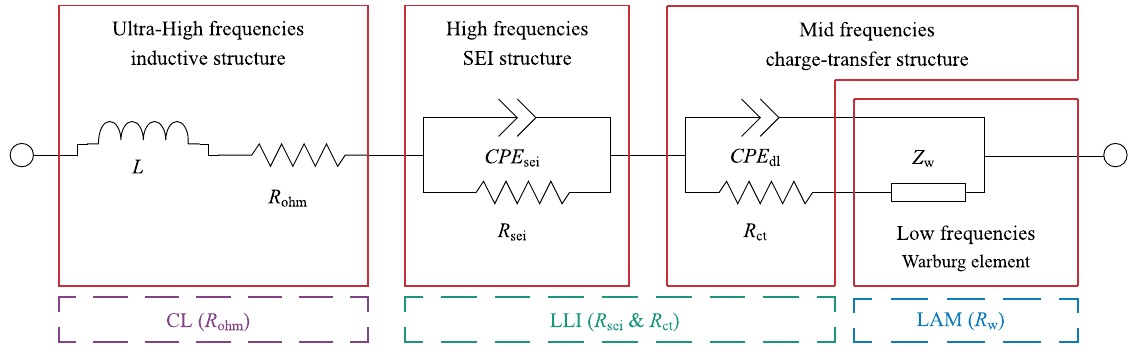
Figure 4. Second-order equivalent circuit